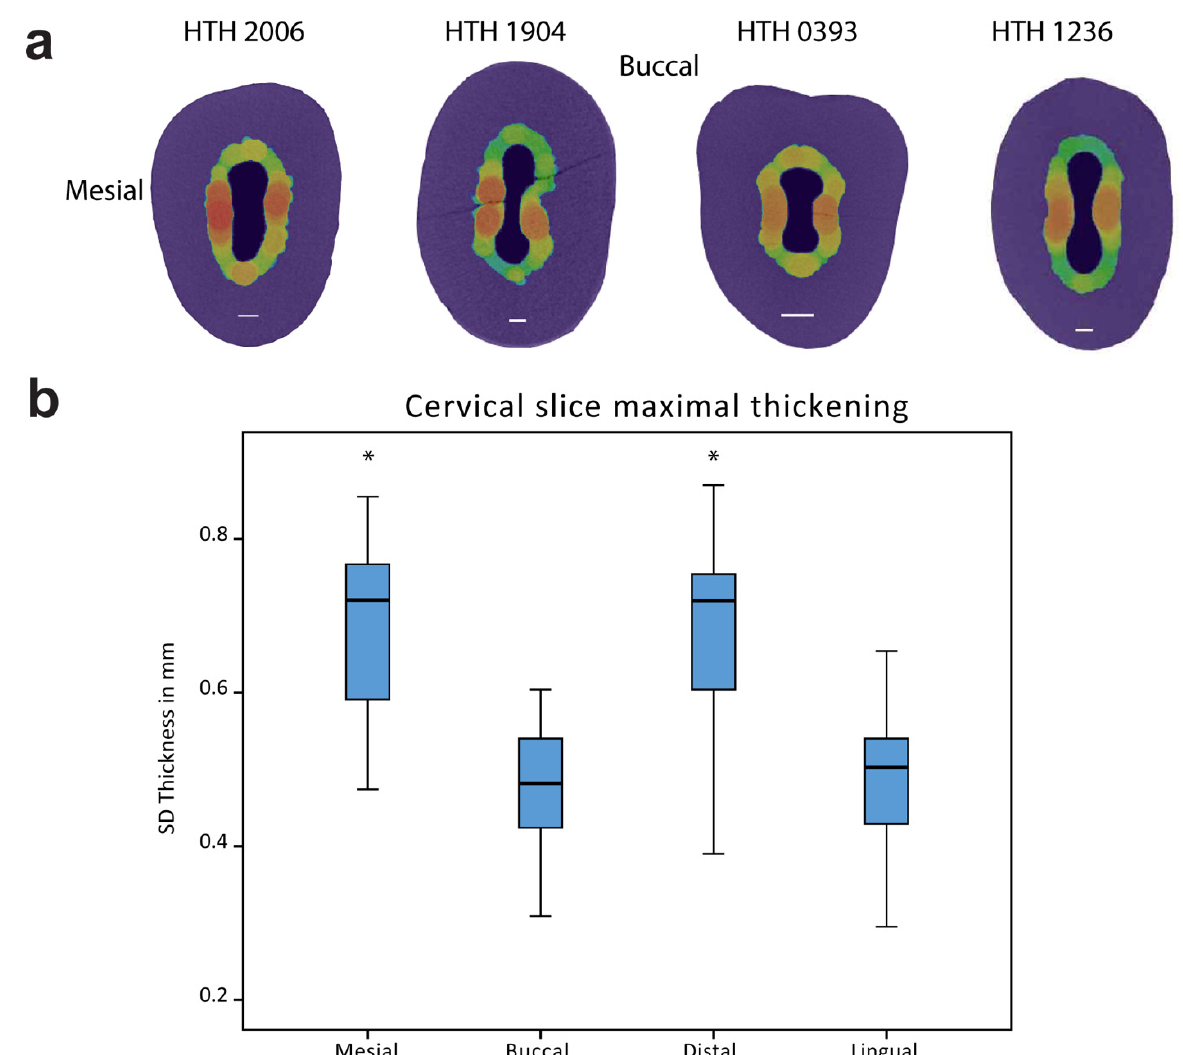
Figure 3. Mesio-distal thickening of SD. ( a ) Horizontal slices at − 1 mm below the CEJ from the four representative teeth. Buccal and mesial directions are on the top and on the right, respectively. SD thickness values are based on the thickness legend. ( b ) Box plot of the SD thickness 1 mm below the CEJ at mesial, buccal, distal, and lingual directions. n =30. * Indicating significant difference at p < 0.05. Significance was found between the mesial and distal to buccal and lingual.